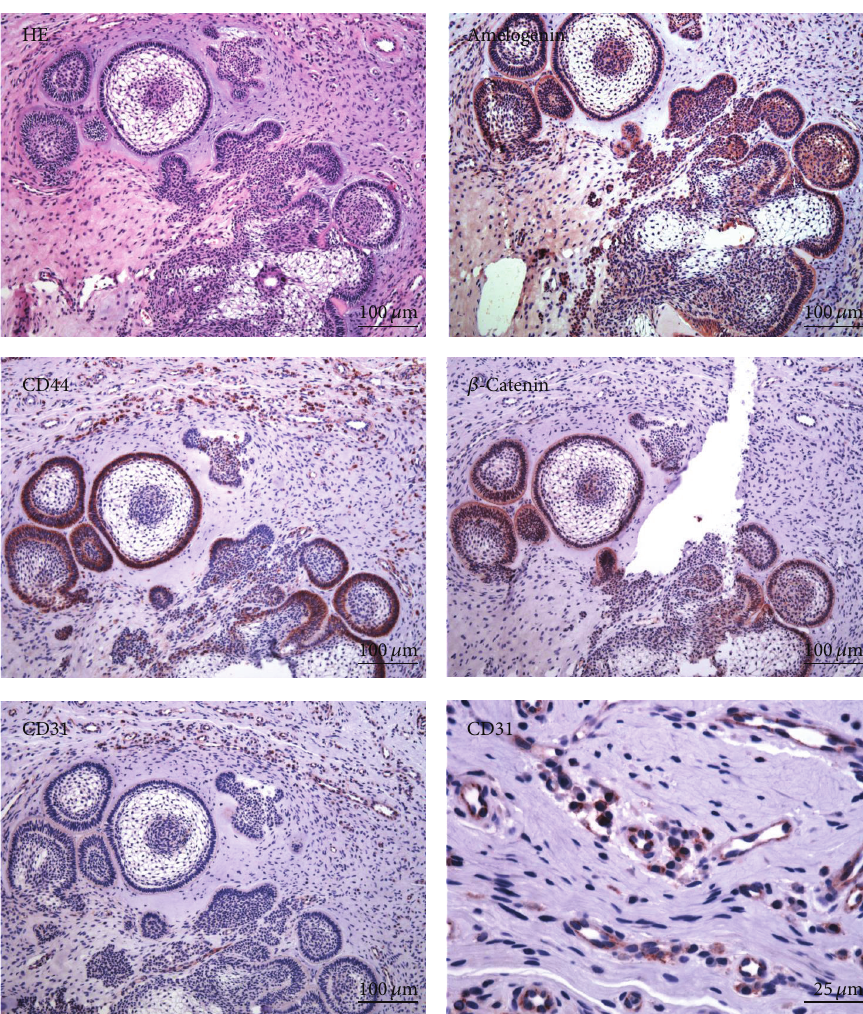
Figure 4: Immunohistochemistry for amelogenin, 𝛽 -catenin, CD31, and CD44. The stainings showed that amelogenin, 𝛽 -catenin, and CD44 were strongly expressed in the enamel epithelial cells. Some of the stromal cells, leukocytes, and endothelial cells were also positive for CD44 staining. CD31 staining appeared in the endothelial cells of the tumor stroma, especially in the area adjacent to the enamel epithelium. Scale bar = 100 𝜇 m for all panels but the bottom right (25 𝜇